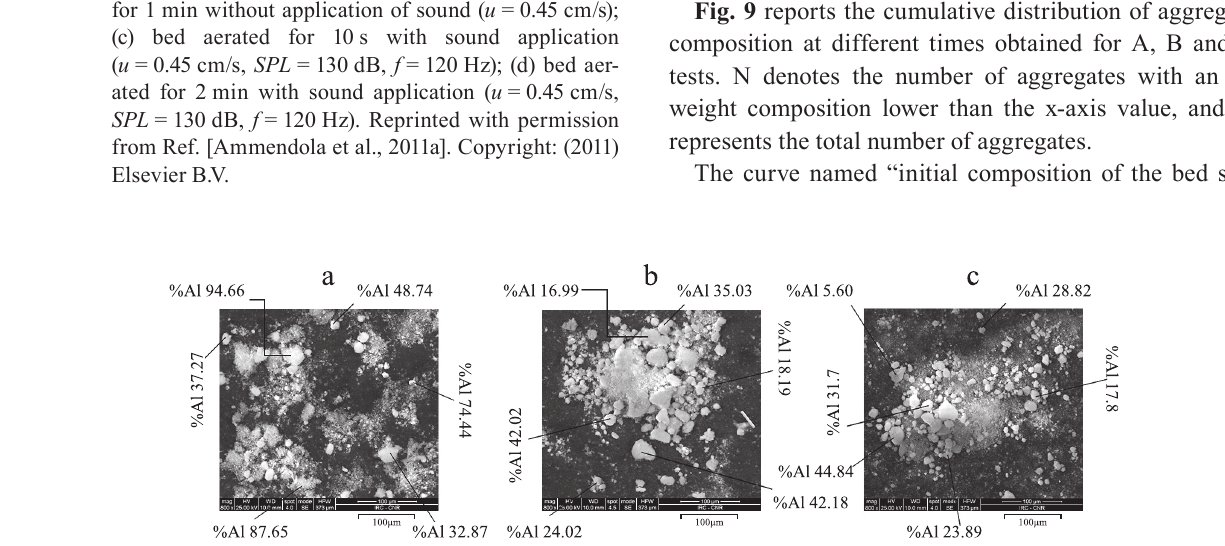
Fig. 7 mixing test: (a) bed made of 15 g of the Al 2 O 3 (white) and 15 g of the Fe 2 O 3 (red) nanopowder; (b) bed aerated